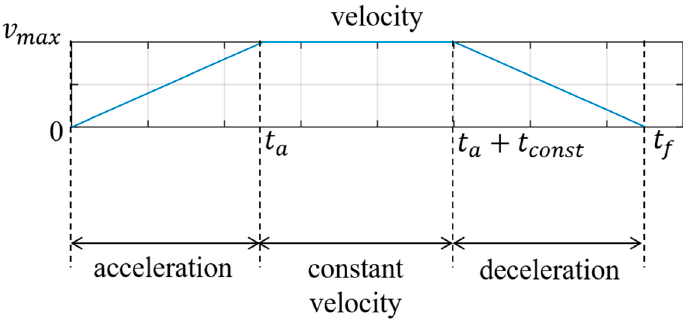
Figure 4. Three sections of trapezoidal motion profile.